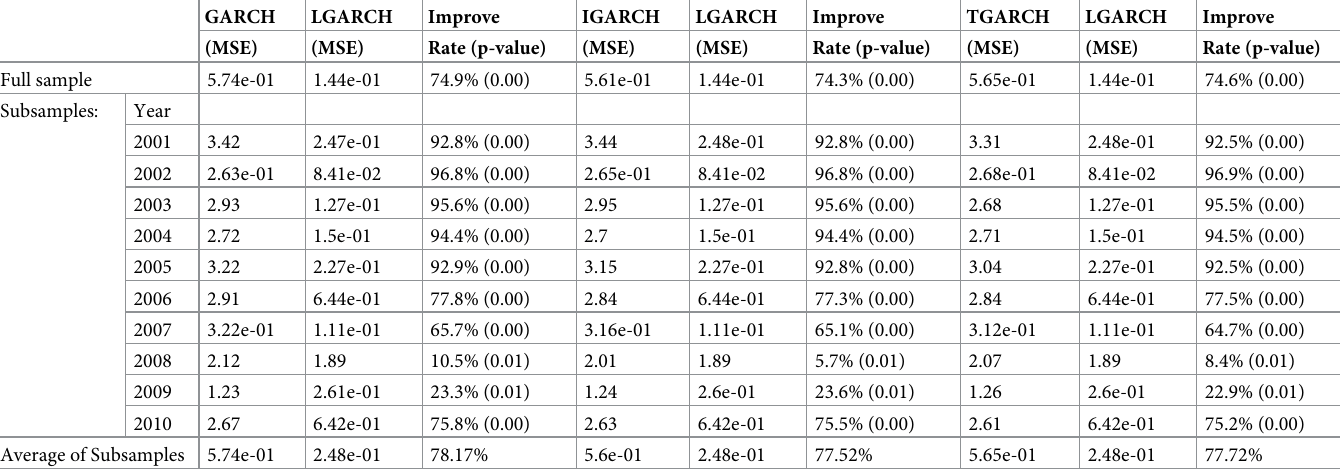
Table 4. In sample fitting with realized variance. This table presents the oil futures volatility in-sample fitting results of Liquidity-adjusted GARCH (LGARCH) with other three GARCH models against the realized variance using the Mean Squared Error (MSE). The p-values for statistical differences of the forecasting errors are also pre- sented. The LGARCH model outweighs all other three models in both full sample and all subsample tests. Where en = � 10 n , e.g. e − 02 = � 10 − 2